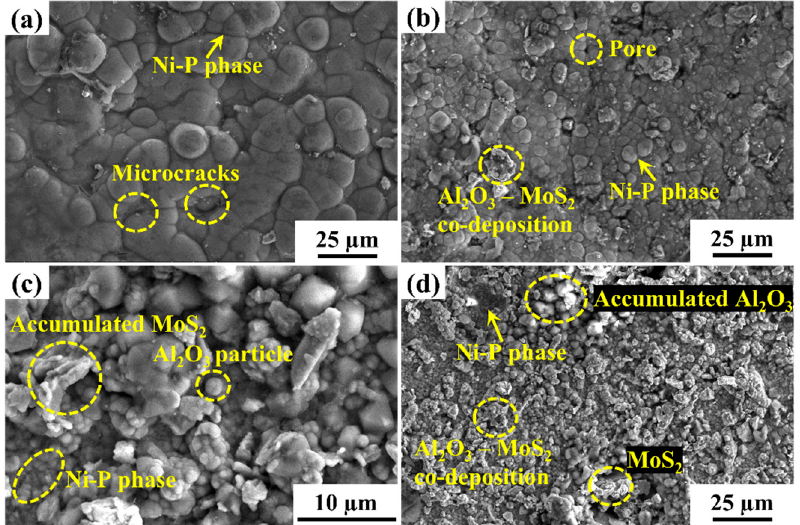
Figure 6. SE images of ( a ) an Ni-P coating without powder; composite coatings with ( b ) 0.5 g/L MoS 2 and 2 g/L Al 2 O 3 , ( c ) 2 g/L MoS 2 and 3 g/L Al 2 O 3 , and ( d ) 2 g/L MoS 2 and 4 g/L Al 2 O 3